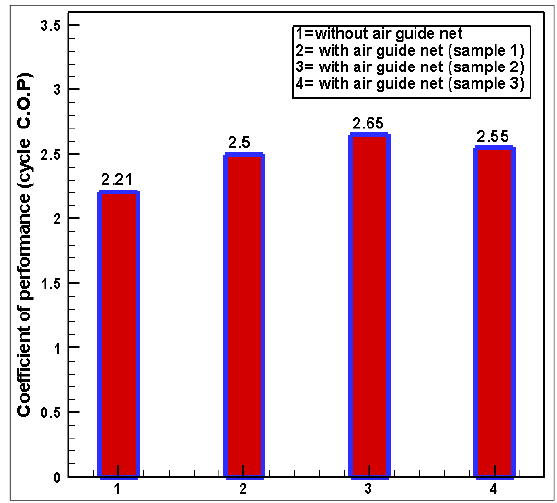
Fig. 6. Graphical representation of cycle C.O.P for the A/C system with and without air guide net.